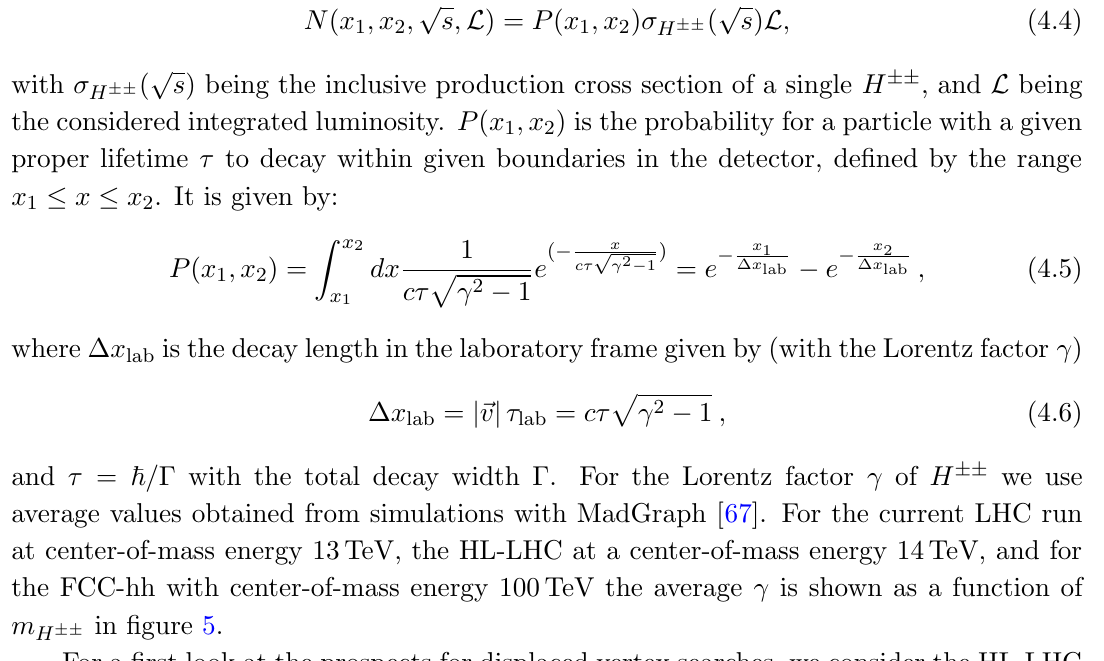
Figure 5 . Average Lorentz factor (cid:13) as a function of m Displaced vertex